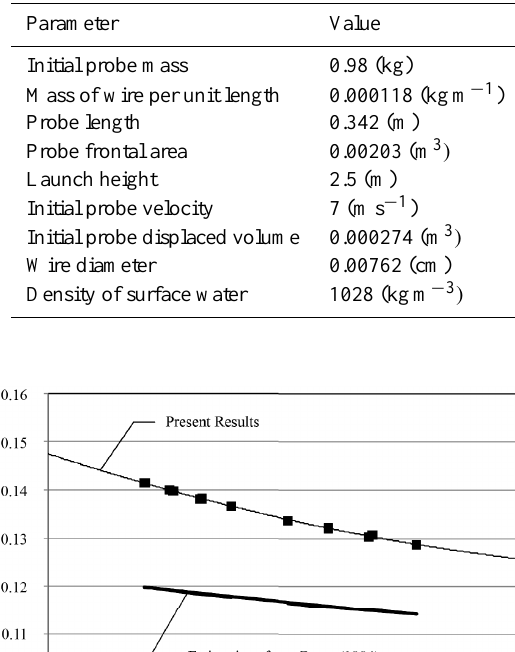
Table 3. Parameter values used for fall calculations.